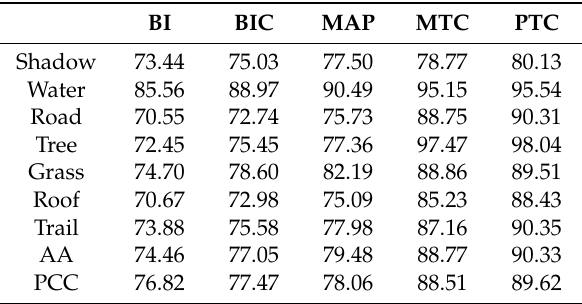
Table 2. Accuracy (%) of five methods in Experiment 1 ( S = 2).